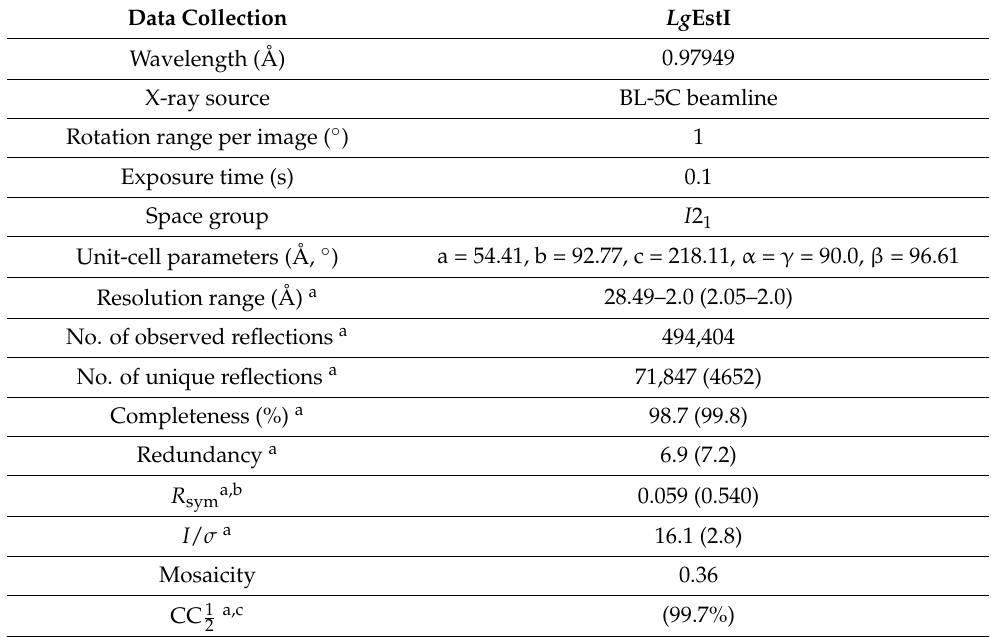
Table 3. X-ray diffraction data collection